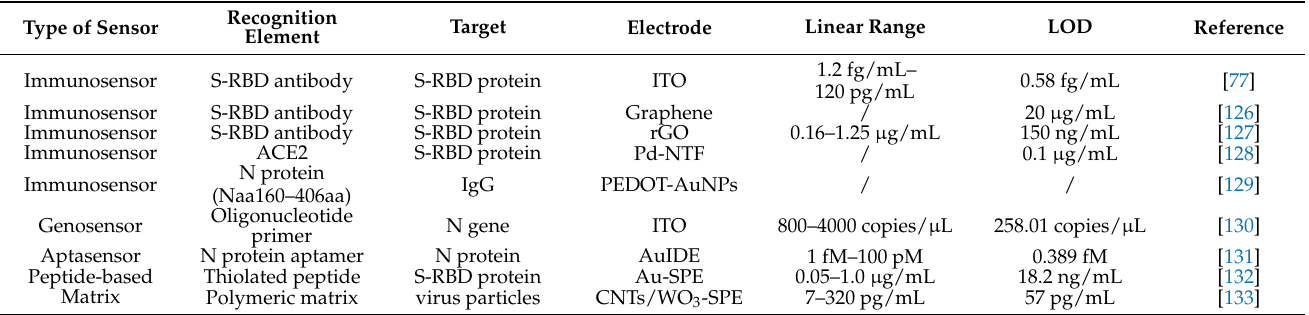
Table 4. Recently developed biosensors for SARS-CoV-2